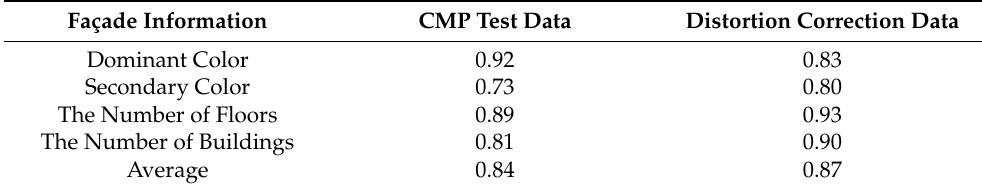
Table 16. Façade information accuracy of CMP test and distortion correction